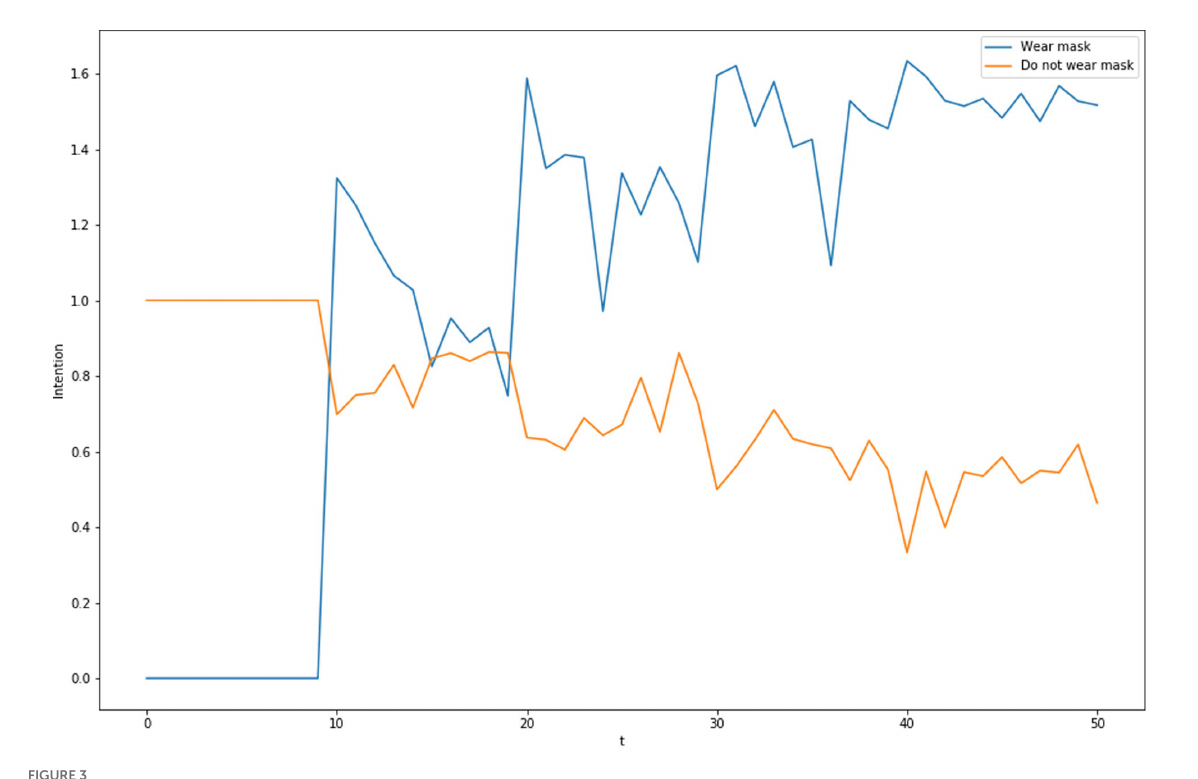
FIGURE 3 Dynamics of subjective intentions for mask wearing or not wearing masks with messaging promoting masks at t = 10, 20, 30, 40.